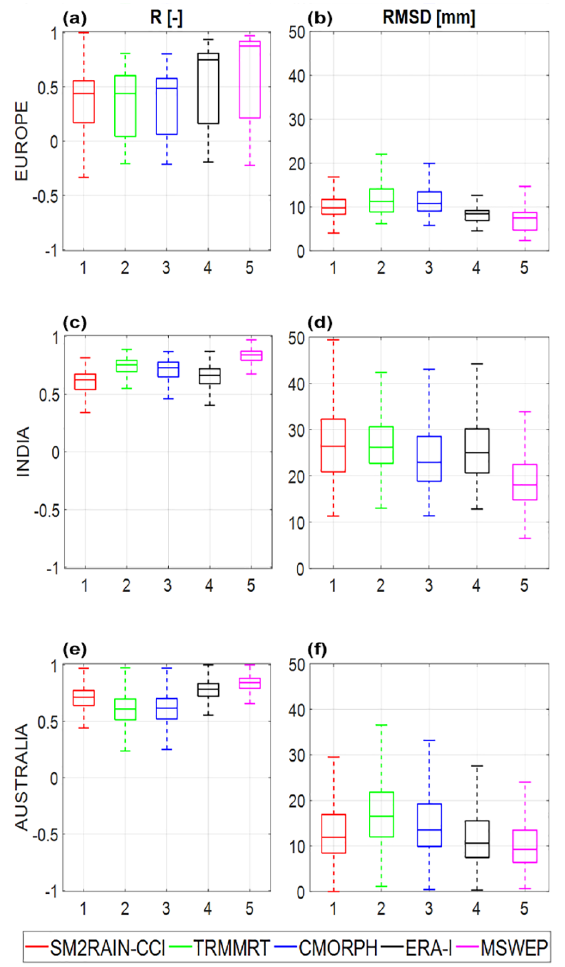
Figure 8. Correlation coefficient (a, c, e) and root mean square difference (RMSD, b, d, f ) box plots obtained by comparing SM2RAIN-CCI (in red), TRMMRT (in green), CMORPH (in blue), ERA-Interim (in black) and MSWEP (in magenta) with gauge- based data sets over Europe (a, b) , India (c, d) and Australia (e, f)